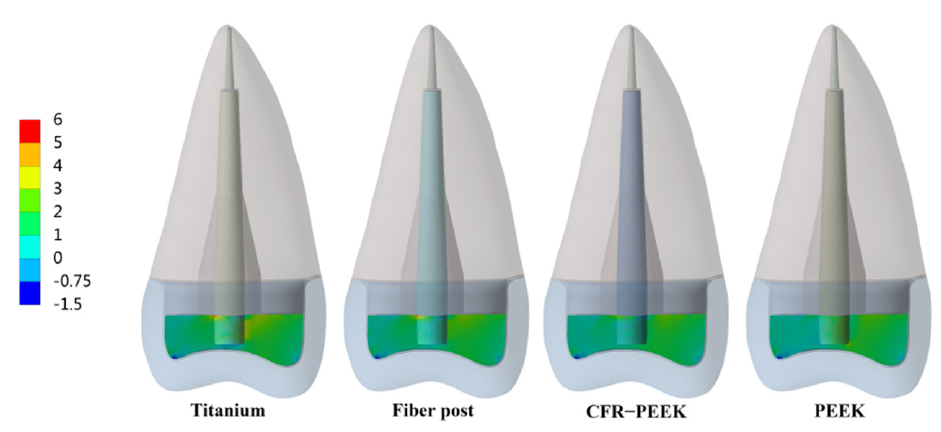
Figure 10. Distributions of MPS at resin core in prototype 2.